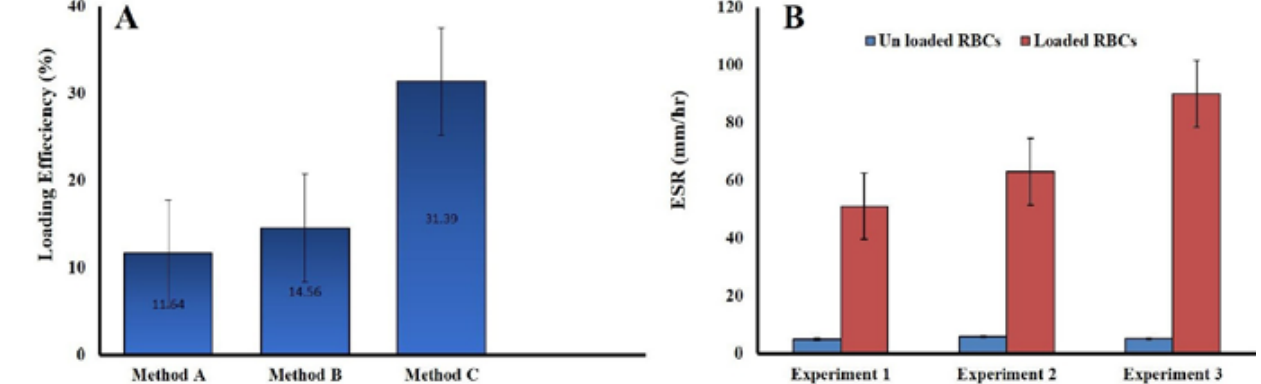
FIGURE 2 - (A) Drug loading efficiency of 3 different method used for erythrocytes. (B) effect of different loading techniques on ESR showing integrity of membrane. The results are presented as Mean ±SD of three